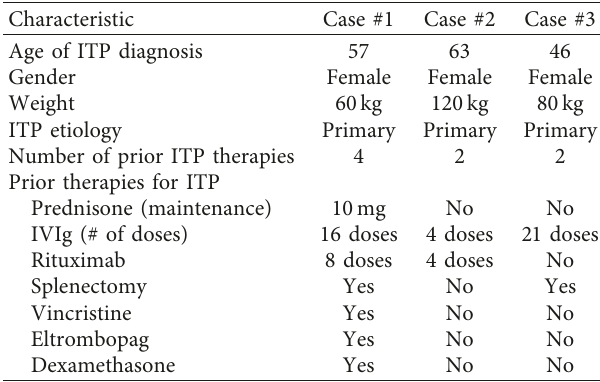
Table 1: Baseline demographic and clinical